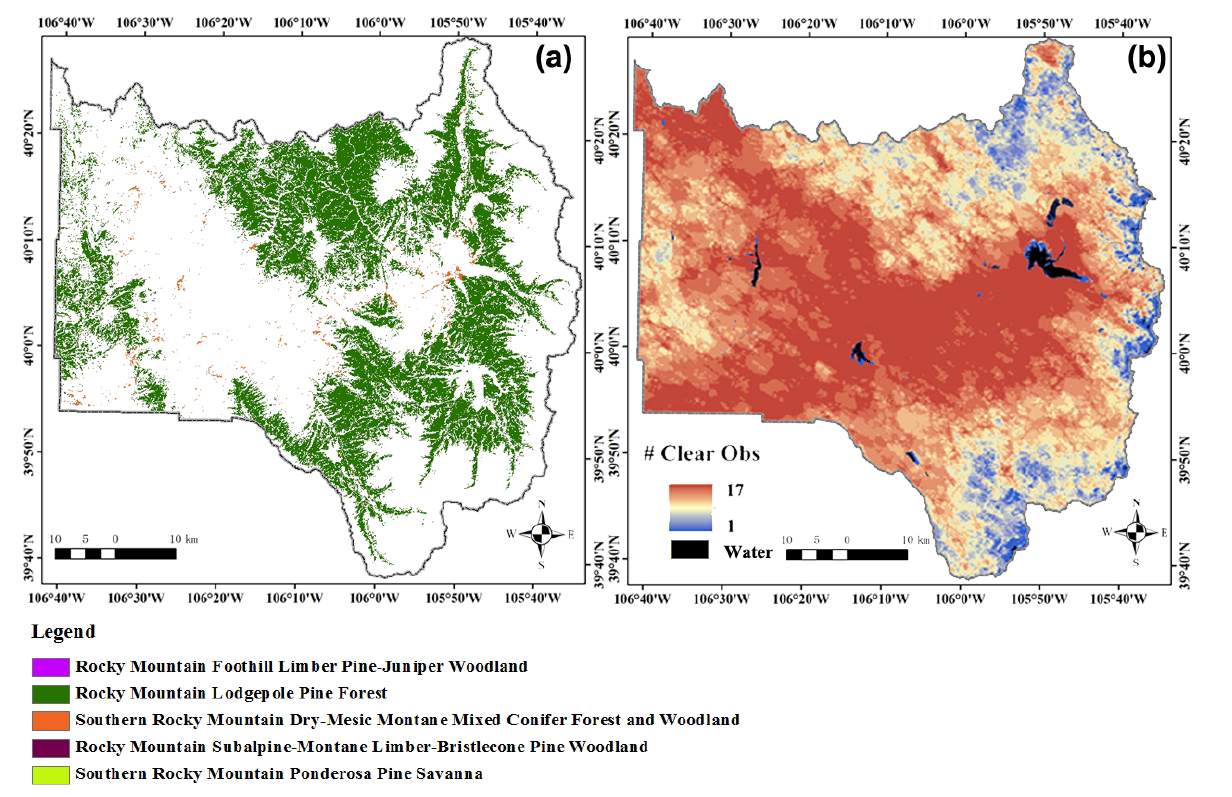
Figure 2. Forest type map for Grand County, from ( a ) the LANDFIRE existing vegetation type data and ( b ) the number of clear Landsat observations over the period of 2000 to